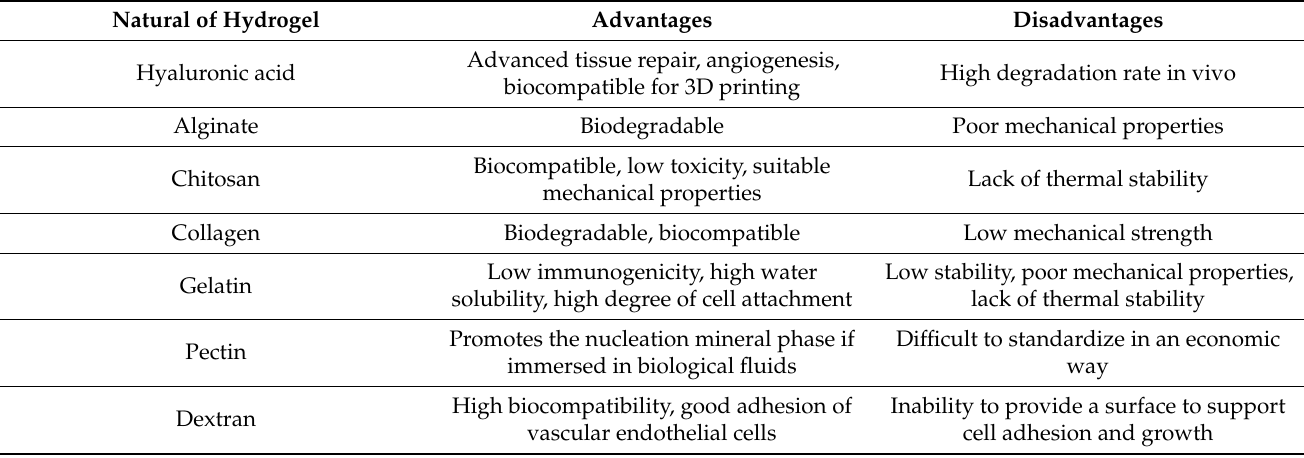
Table 1. A representative list of the most common commercially available natural hydrogels for bone regeneration. Natural of Hydrogel Advantages Disadvantages Advanced tissue repair, angiogenesis, Hyaluronic acid High degradation rate in vivo biocompatible for 3D printing Alginate Biodegradable Poor mechanical properties Biocompatible, low toxicity, suitable Chitosan Lack of thermal stability mechanical properties Collagen Biodegradable, biocompatible Low mechanical strength Low immunogenicity, high water Low stability, poor mechanical properties, Gelatin lack of thermal stability solubility, high degree of cell attachment Promotes the nucleation mineral phase Pectin